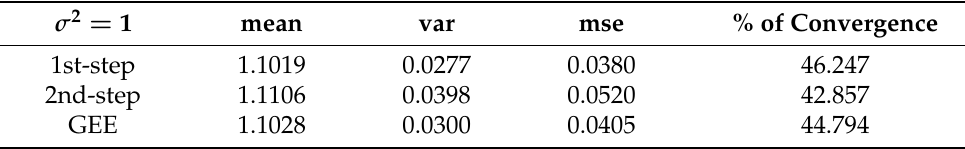
Table 3. estimate σ 2